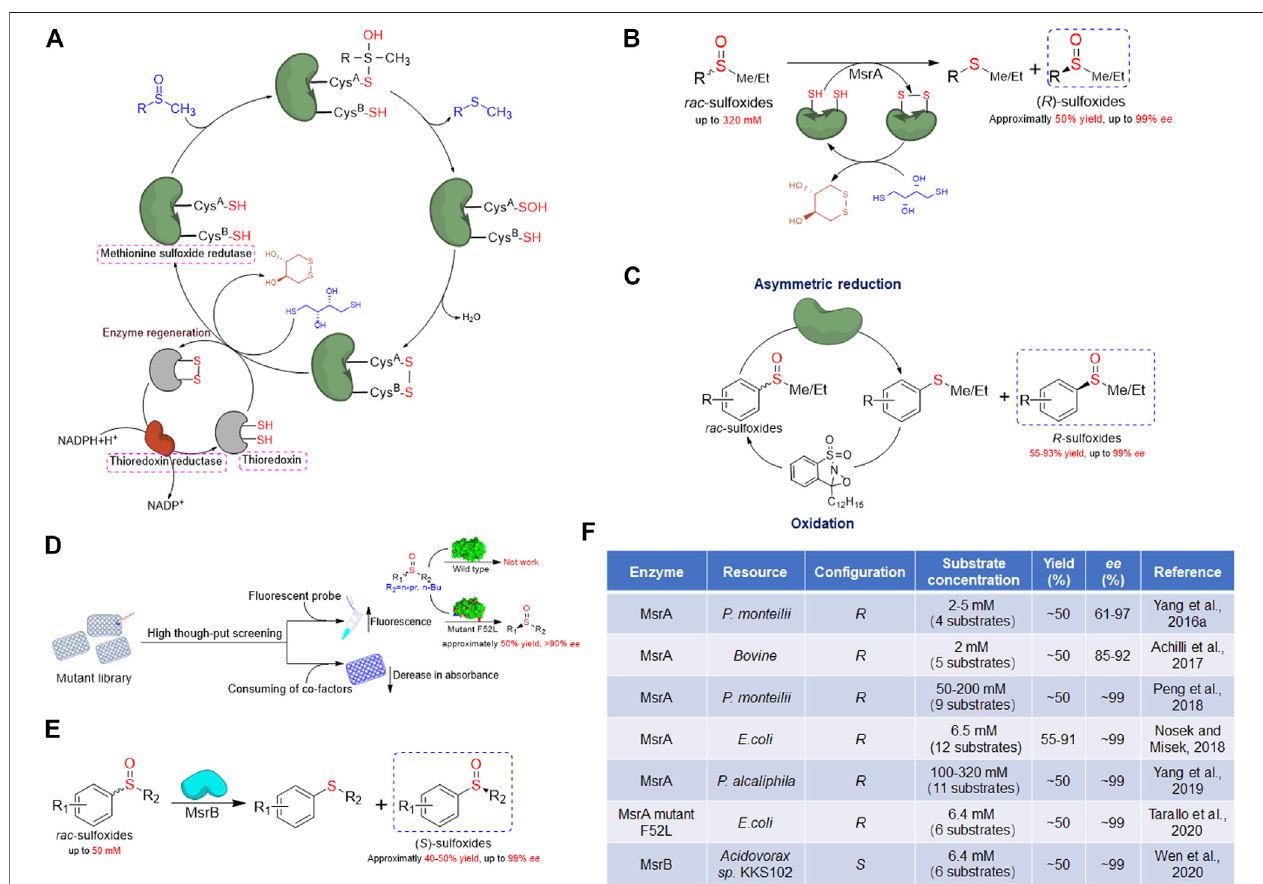
FIGURE 1 | Overview of methionine sulfoxide reductase and application in chiral sulfoxides preparation. (A) General catalytic mechanism of methionine sulfoxide reductase. (B) Schematic presentation of kinetic resolution catalyzed by MsrA for ( R )-sulfoxides preparation. (C) Schematic presentation of cascade chemoenzymatic reaction for ( R )-sulfoxides preparation by MsrA and oxaziridine. (D) Schematic presentation of high-throughput screening strategies of MsrA and the latest achievement in modi fi cation of substrate scope. (E) Schematic presentation of kinetic resolution catalyzed by MsrB for ( S )-sulfoxides preparation. (F) Summary of Msr enzymes applied for preparation of chiral sulfoxides through kinetic